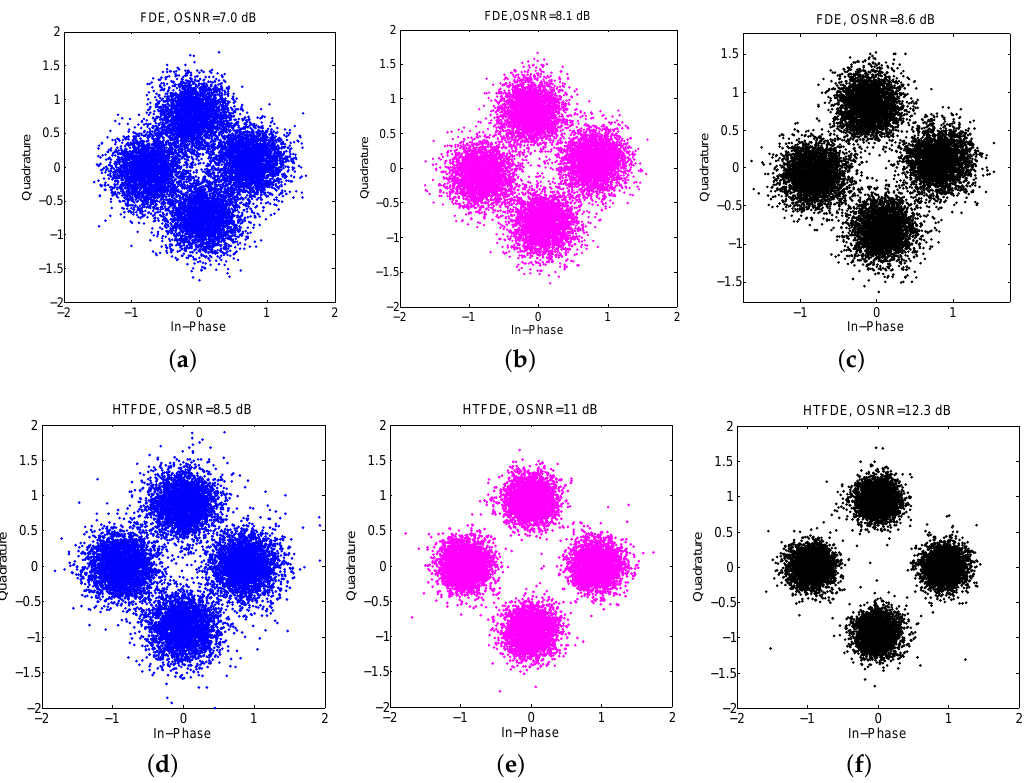
Figure 11. Scatterplot of the equalized first packet signal using the five transmissions with conventional FDE and HTFDE: ( a ) using the 1st element with FDE; ( b ) using elements 1 and 2 with FDE; ( c ) using elements 1 to 3 with FDE; ( d ) using the 1st element with HTFDE; ( e ) using elements 1 and 2 with HTFDE; ( f ) using elements 1 to 3 with